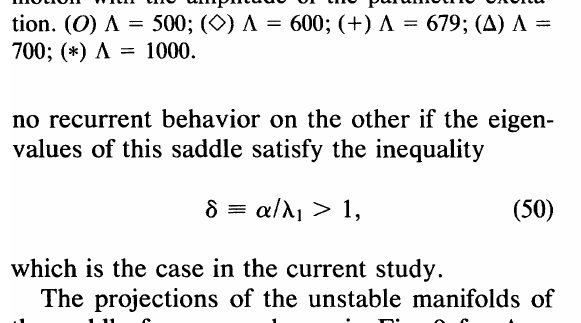
FIGURE 8 Variation of the period of the periodic motion with the amplitude of the parametric excita tion. (0) A = 500; (0) A = 600; (+) A = 679; (M A = 700; (*) A = 1000.